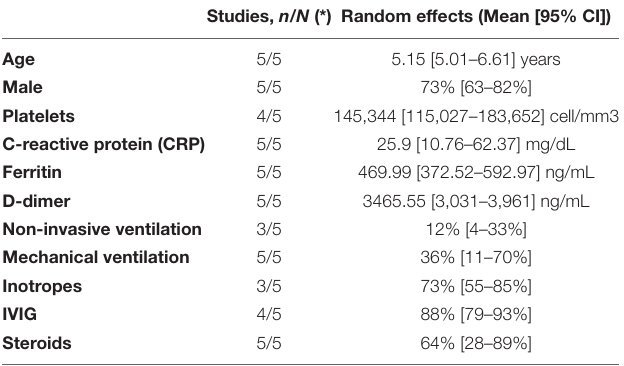
TABLE 4 | Pooled meta-analyses in MIS-C patients admitted to the PICU. Studies, n / N (*) Random effects (Mean [95%